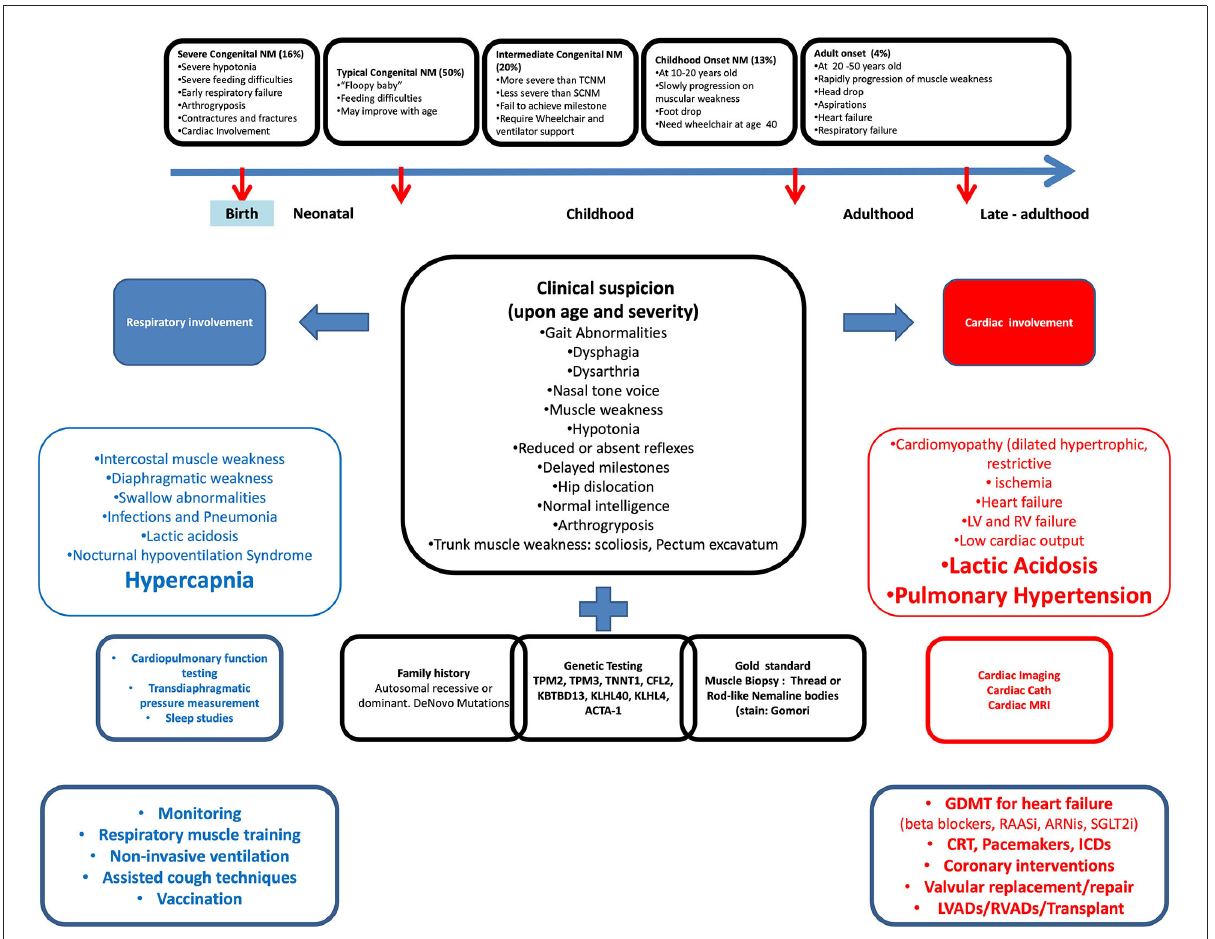
FIGURE3 Cardiopulmonary involvement in nemaline myopathy from clinical presentation to